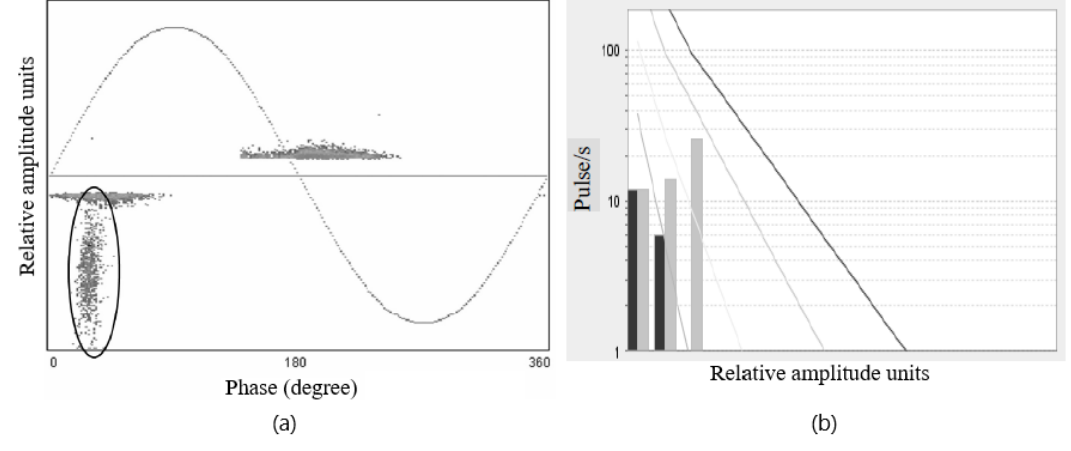
Figure 11. ( a ) PRPD pattern, ( b ) 2D equivalent